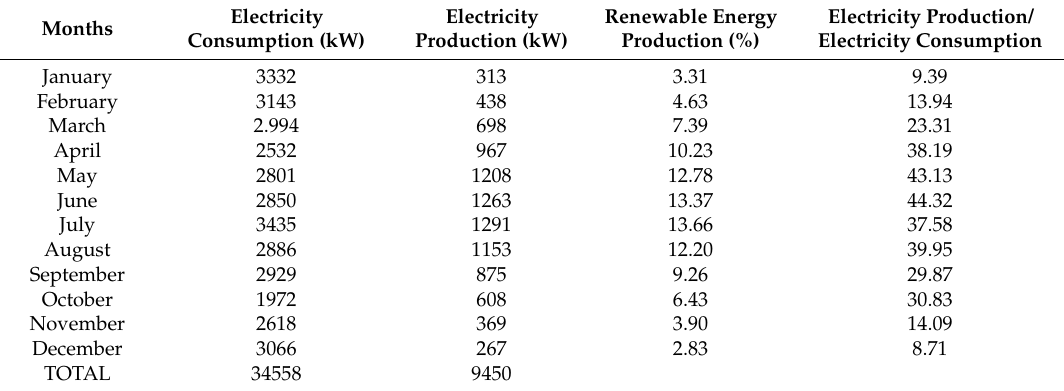
Table 7. Amount of energy consumed and generated monthly by PV panels in Istanbul Erke Green Academy Building Project